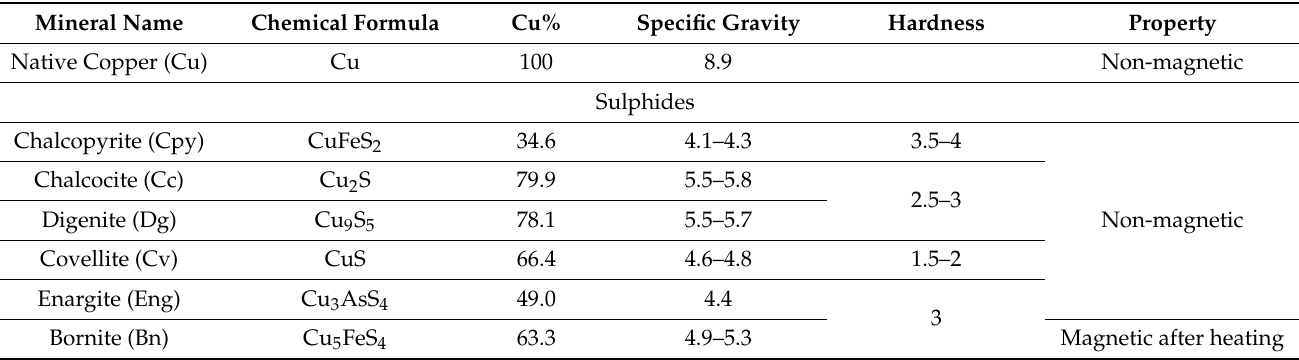
Table 3. Major copper-bearing minerals, along with their physical properties